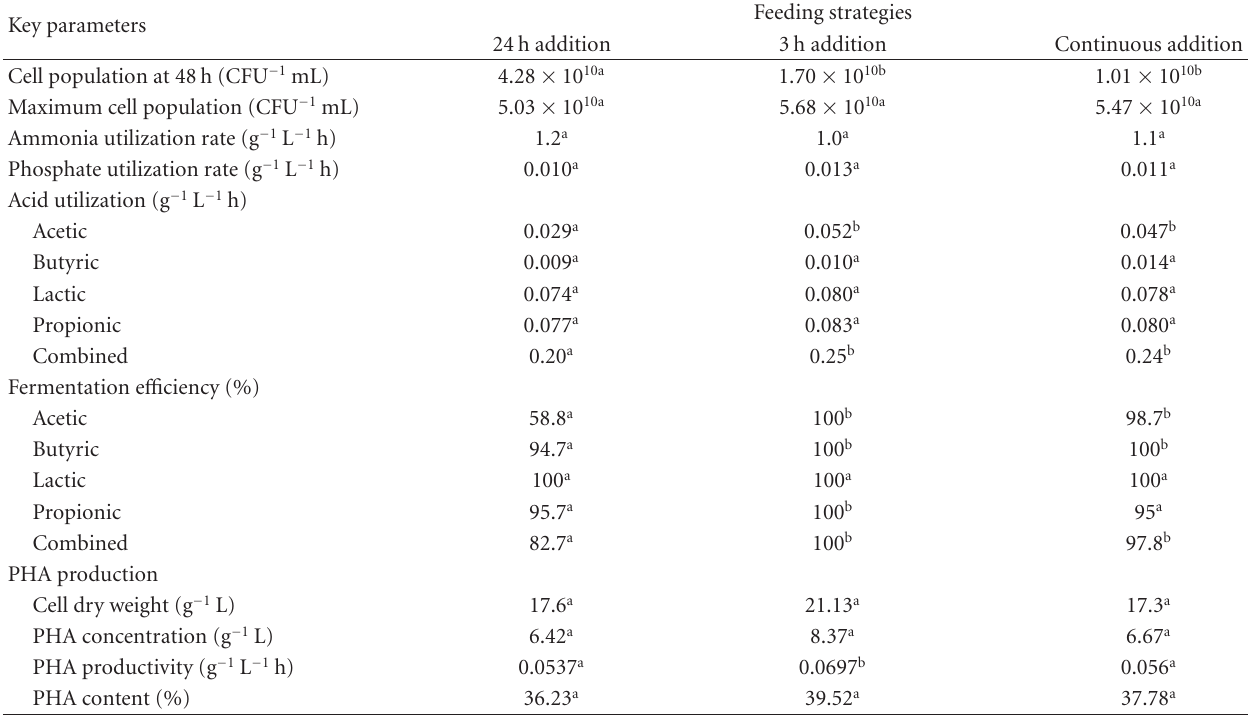
Table 4: Comparison of all the key parameters under di ff erent ARF feeding strategies.